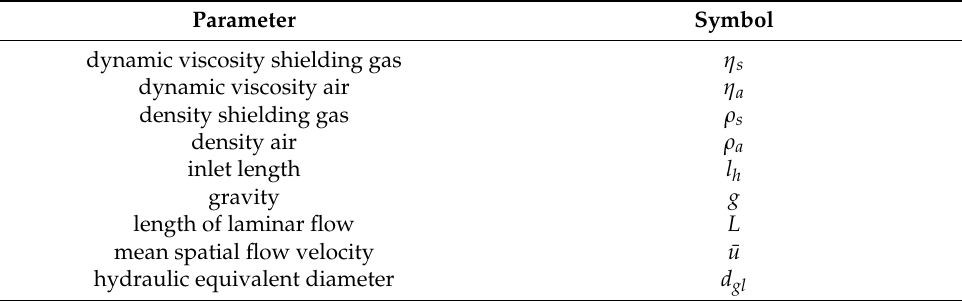
Table 2. Parameters considered for calculation of dimensionless numbers.